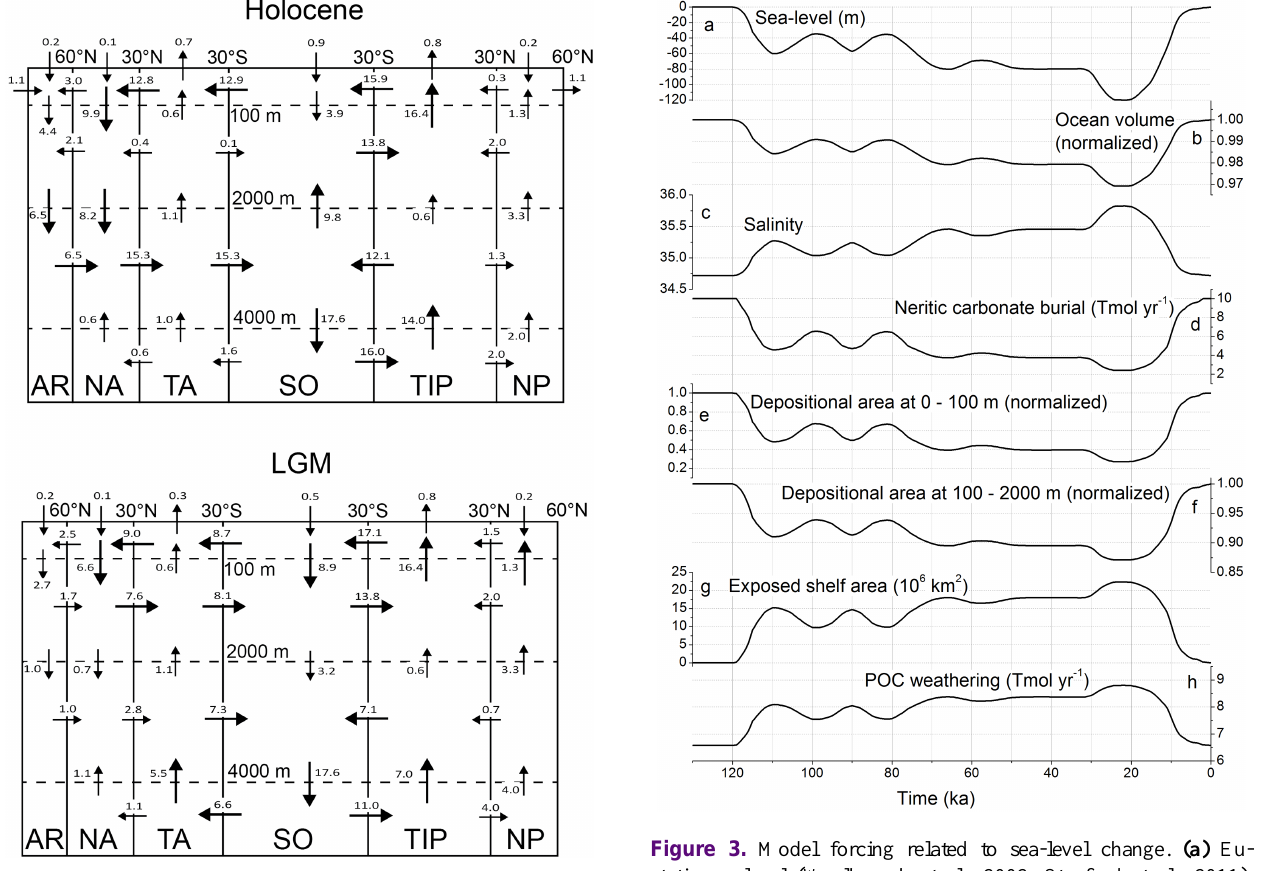
Figure 2. Set-up of the box model: the global ocean is separated into 24 boxes representing surface (0–100m), intermediate (100– 2000m), deep (2000–4000m), and bottom (>4000m) waters in the Arctic (AR), North Atlantic (NA), Tropical Atlantic (TA), Southern Ocean (SO), Tropical Indo-Pacific (TIP), and North Pacific (NP). Arrows with numbers indicate net water fluxes between boxes in Sv; major fluxes (>5Sv) are represented by large arrows, minor fluxes (<5Sv) by small arrows. Arrows crossing the top boundary of the surface water boxes (seawater–atmosphere interface) indicate net freshwater fluxes (precipitation + river water fluxes – evapora- tion). The upper panel shows the circulation field applied for the modern ocean and the previous interglacial; the lower panel shows the circulation applied over the LGM.